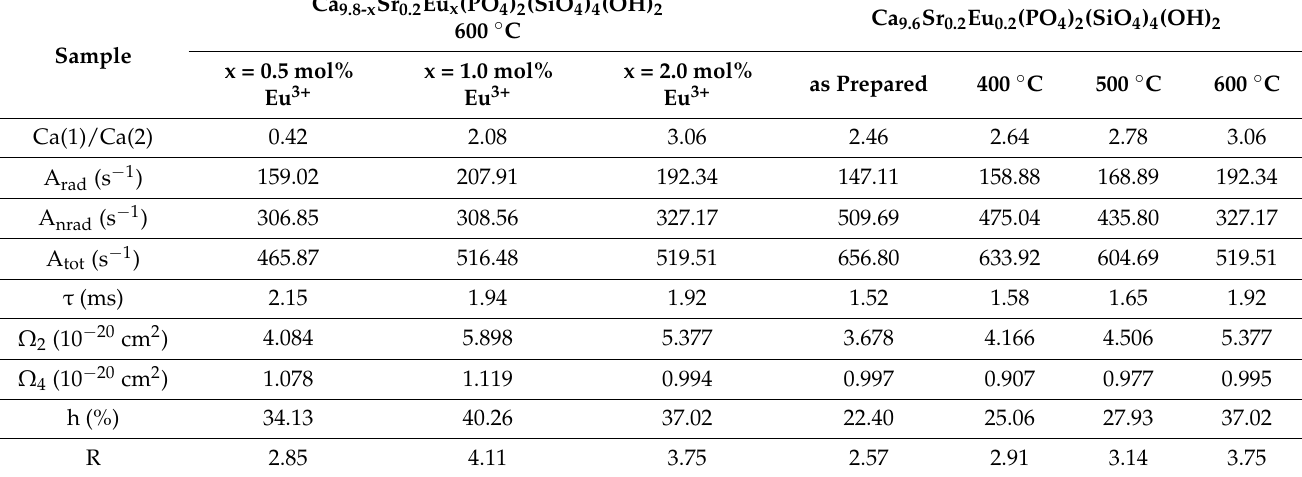
Table 1. Decay rates of radiative (A rad ), non-radiative (A nrad ) and total (A tot ) processes of 5 D 0 → 7 F J transitions, lumi- nescence lifetimes ( τ ), intensity parameters ( Ω 2 , Ω 4 ), quantum efficiency ( η ) and asymmetry ratio (R) for investigated